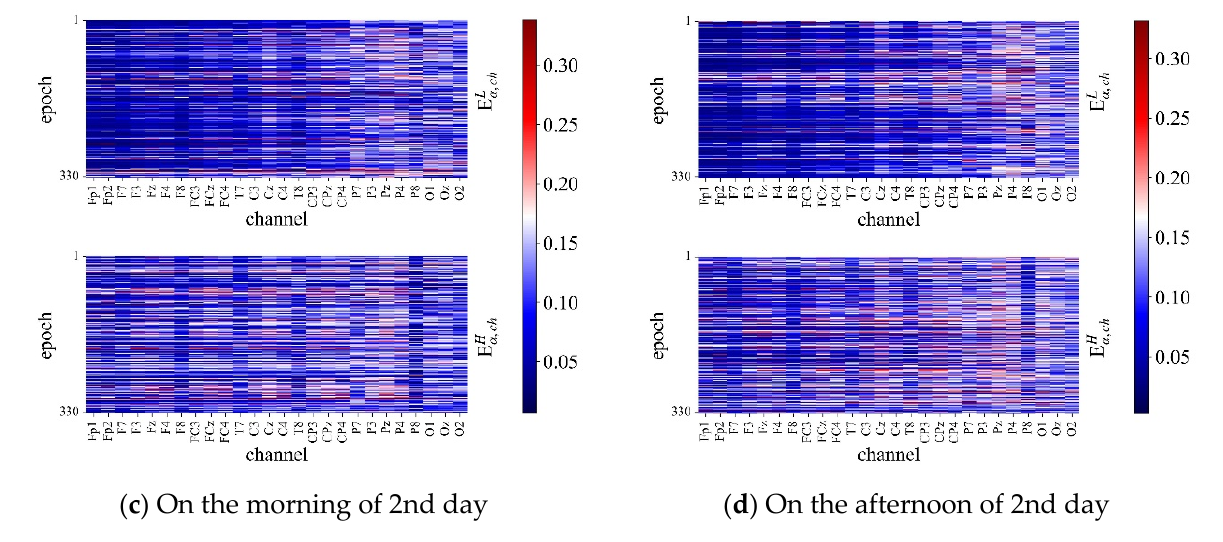
Figure 4. Energy–channel–epoch heatmaps of α rhythm for Sub 8 in 1st to 4th experimental periods.